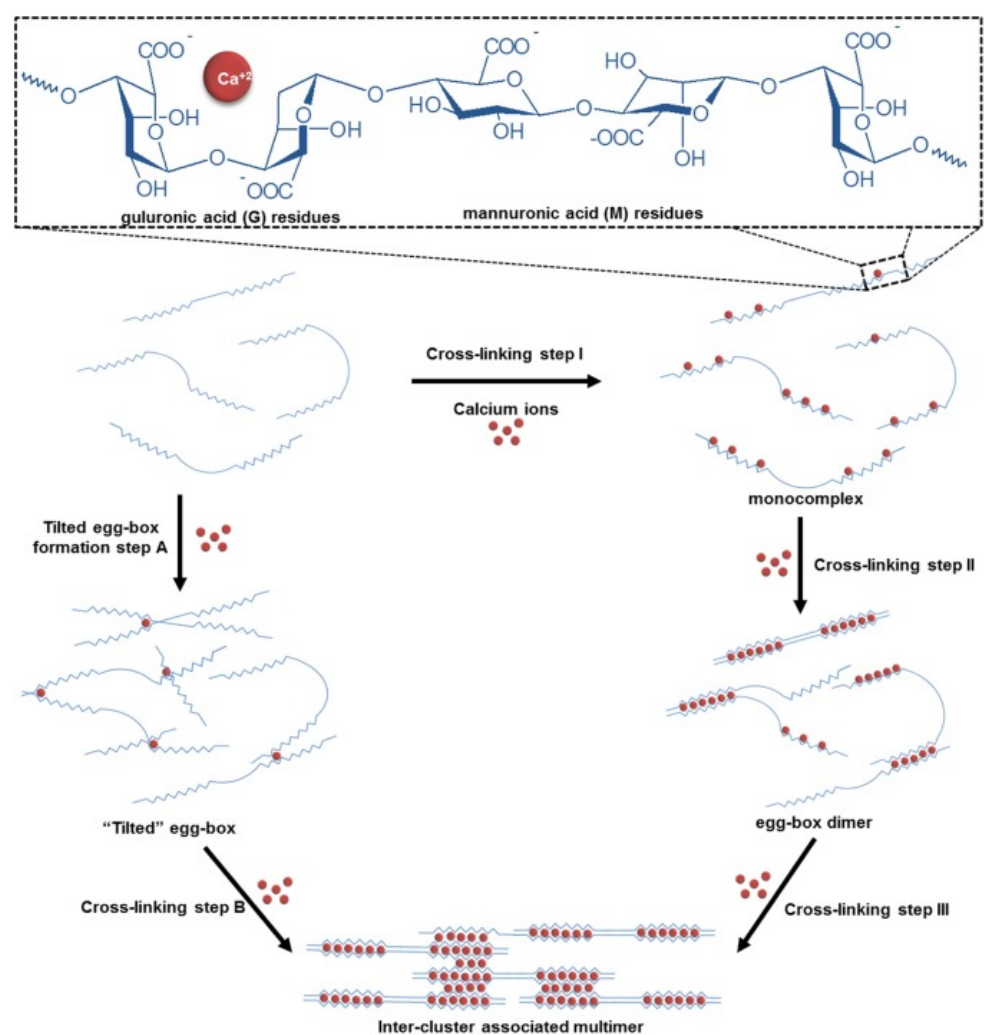
Figure 3. Schematic diagram showing the steps involved in calcium ion-induced crosslinking of the alginate (right, steps I–III) as suggested by Fang et al. [40] and (left, steps A and B) Borgogna et al. [41]. Reproduced from [45] with permission. et al. [41]. Reproduced from [45] with